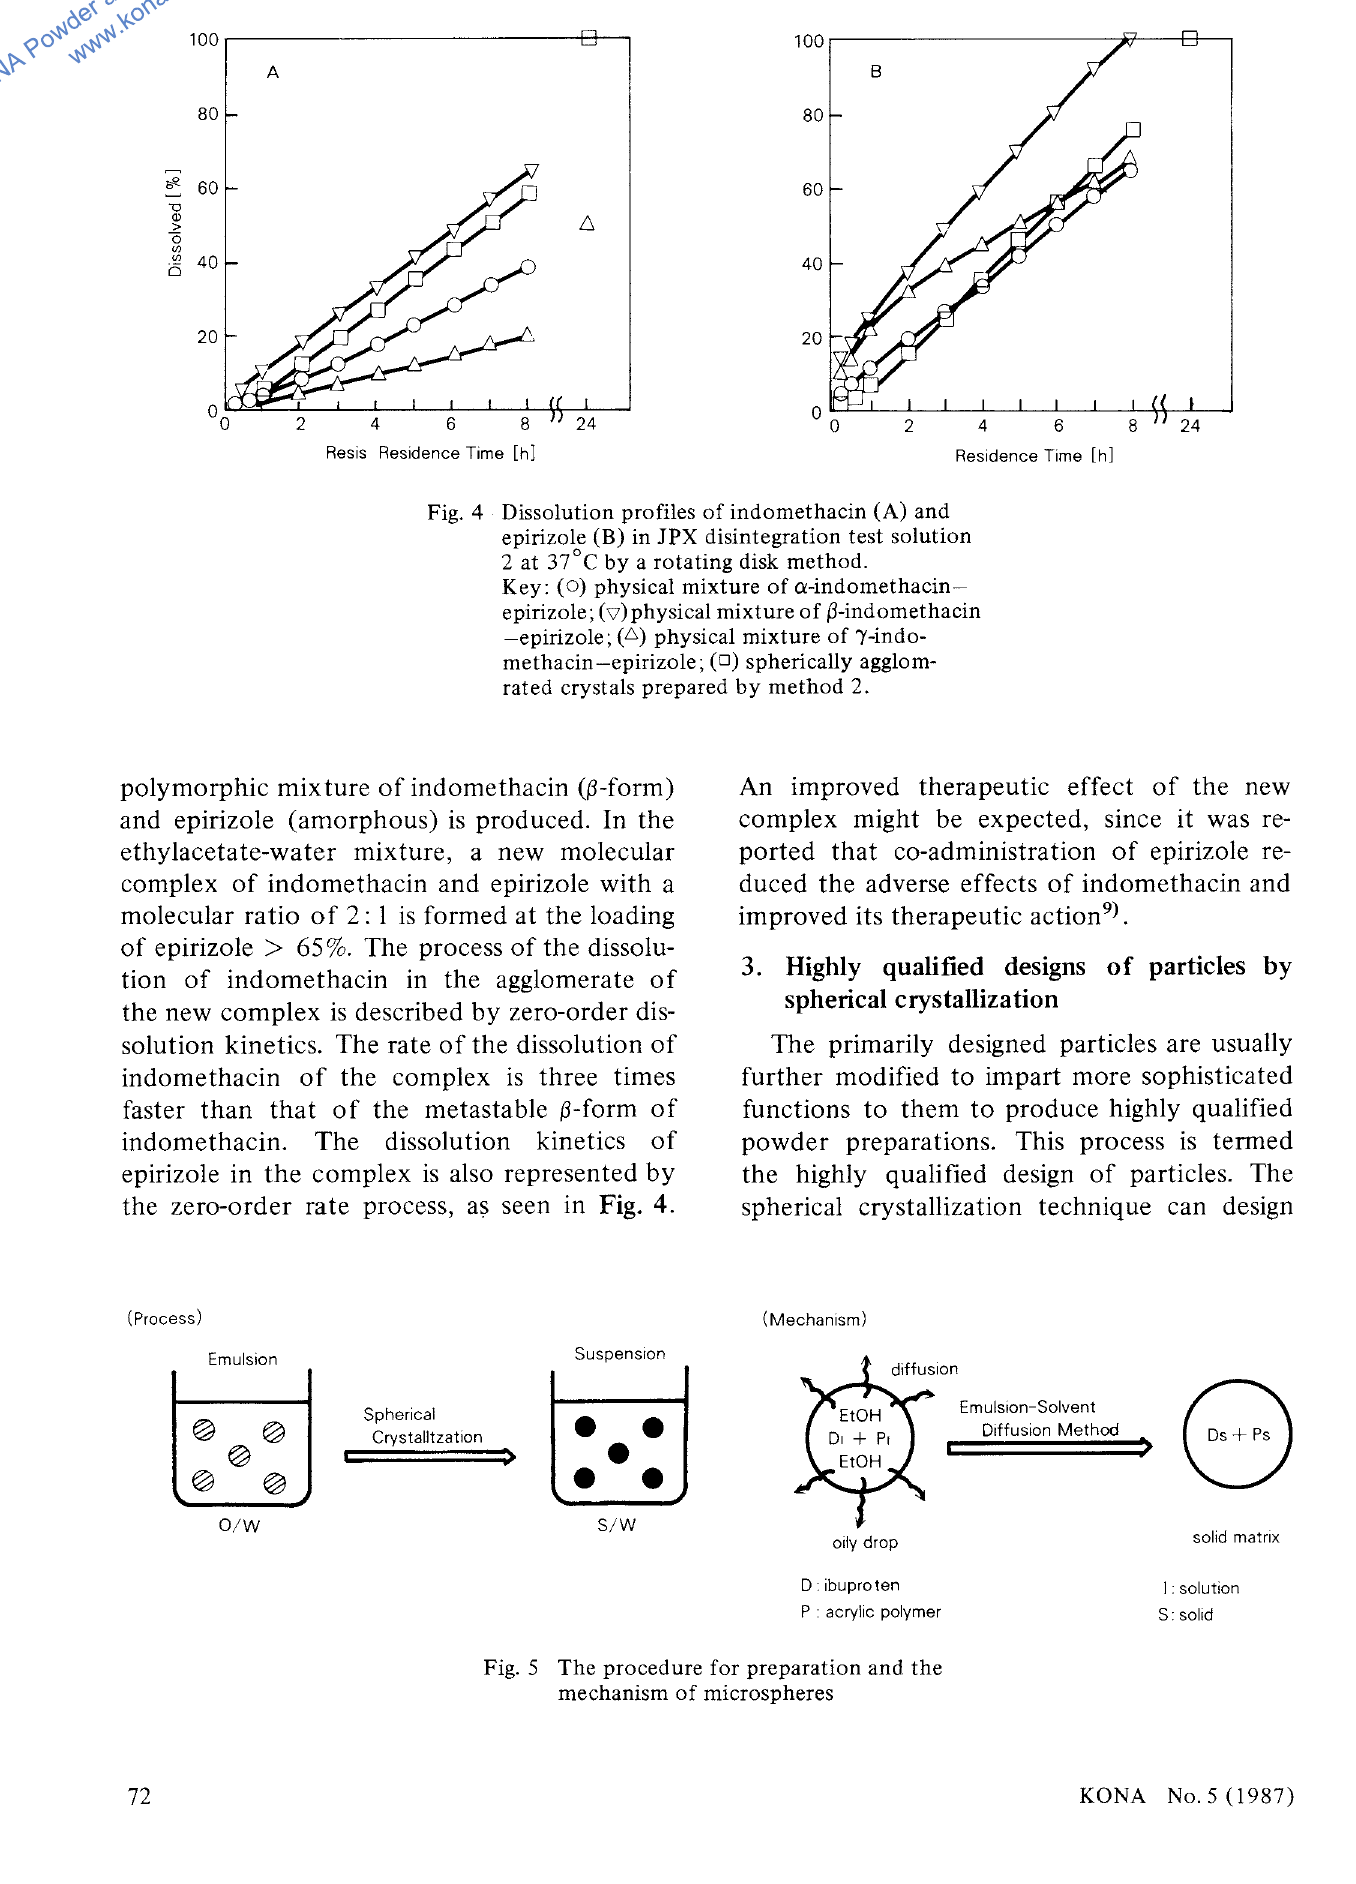
Fig. 5 The procedure for preparation and the mechanism of